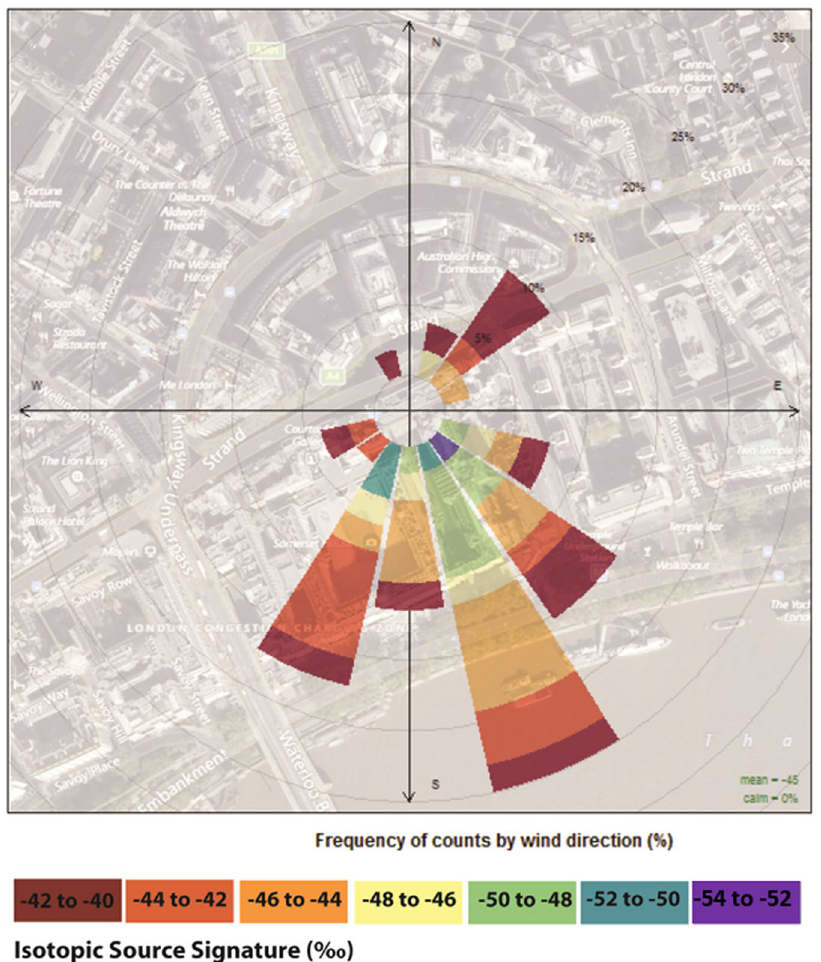
Figure 3. δ 13 C source signature rose for the KCL site for all diurnal campaigns between 2 nd December 2013 and 8 th August 2014, plotted using OpenAir software. The plot includes all episodes with maximum methane mole fractions at least 100 ppb higher than the background, associated with recorded wind directions (wind speed > 0 m s − 1 ). Map data: Google,